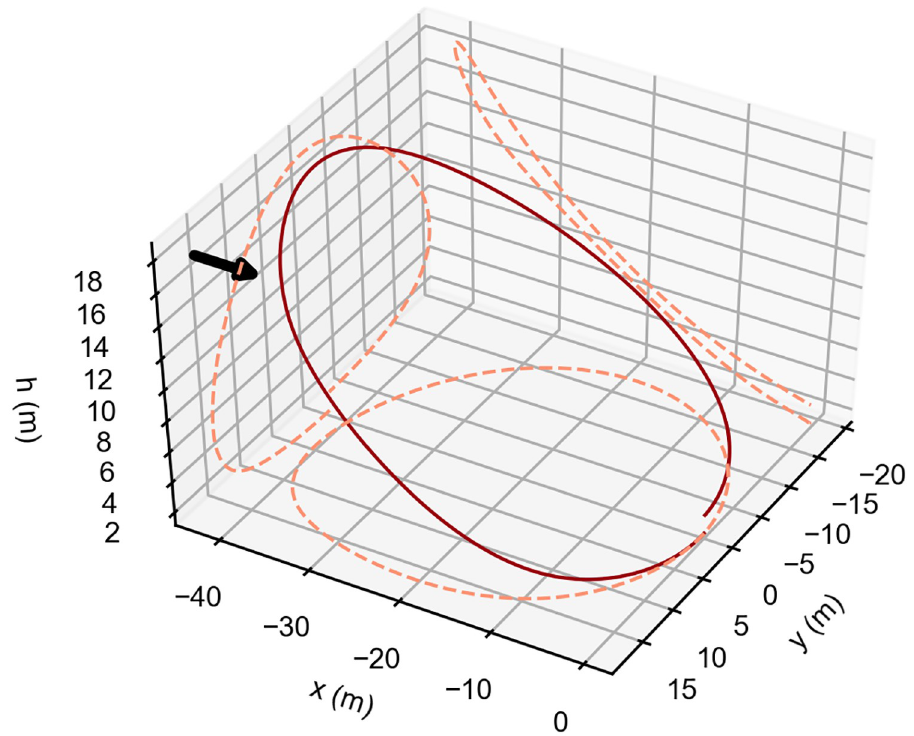
Fig 15. Other possible approaches. Example of dynamic soaring trajectory with altitude gain of 1 meter at the end of one loop and without loss of kinetic energy.